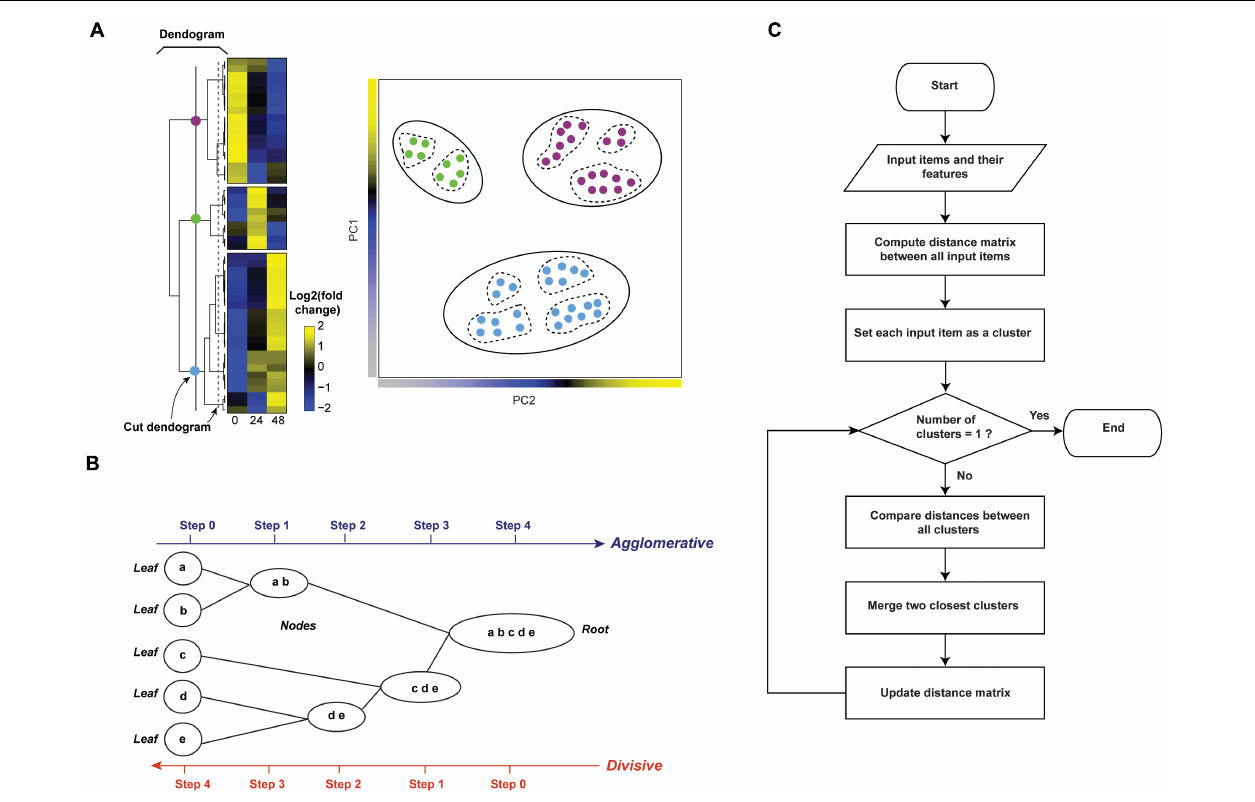
FIGURE 3 | Hierarchical clustering. (A) Relative abundances of 50 proteins across three time points were clustered by hierarchical clustering (left panel). The dendrogram reflects relationships between proteins. The tree was cut at two levels indicated by colored circles and a dashed line to yield 3 and 9 clusters, respectively. The separation of subclusters is illustrated in the PCA plot in the right panel. Here, each dot represents a protein. (B) Agglomerative and divisive are the two types of hierarchical clustering. The agglomerative works in bottom-up manner, recording the sequence of cluster merges. The divisive algorithm works in a top-down manner, recording the sequence of cluster splits. (C) Flowchart of unsupervised hierarchical clustering algorithm